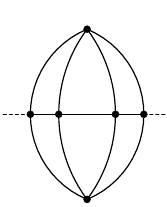
Figure 12 . Amputated two-point diagram obtained by opening any edge in the graph of figure